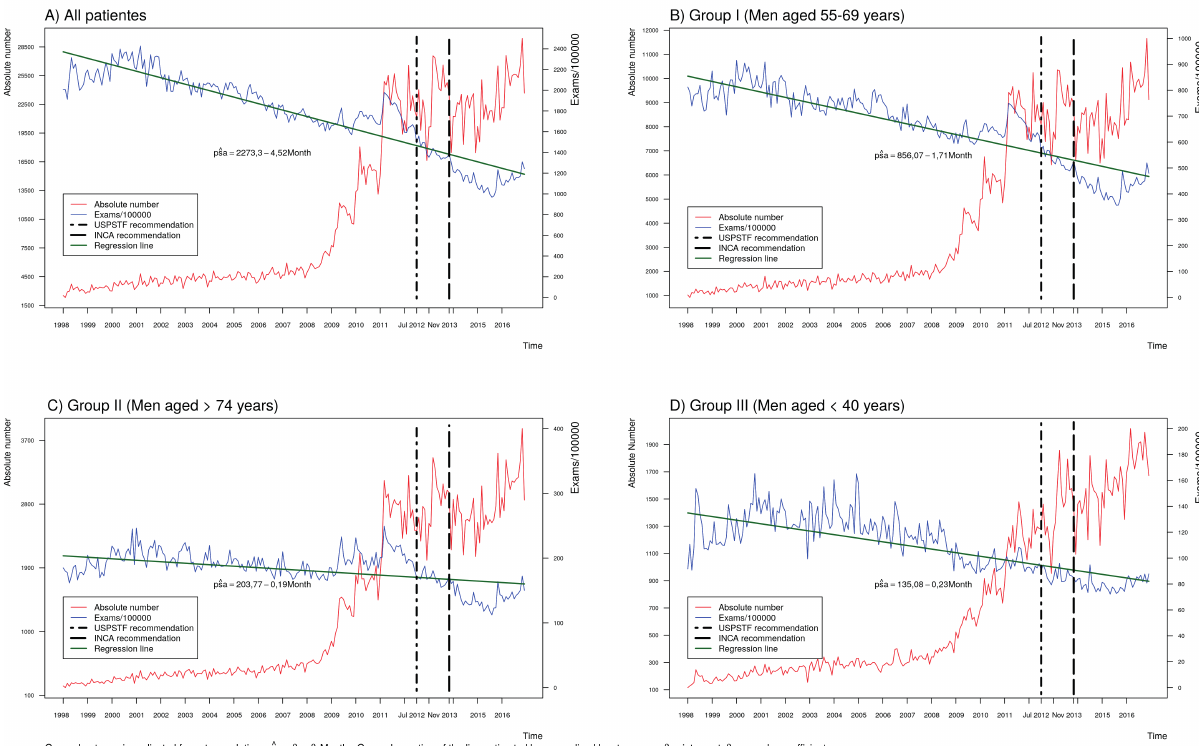
Figure 1 - Use of PSA for Prostate Cancer Screening, Brazil, 1997-2016.